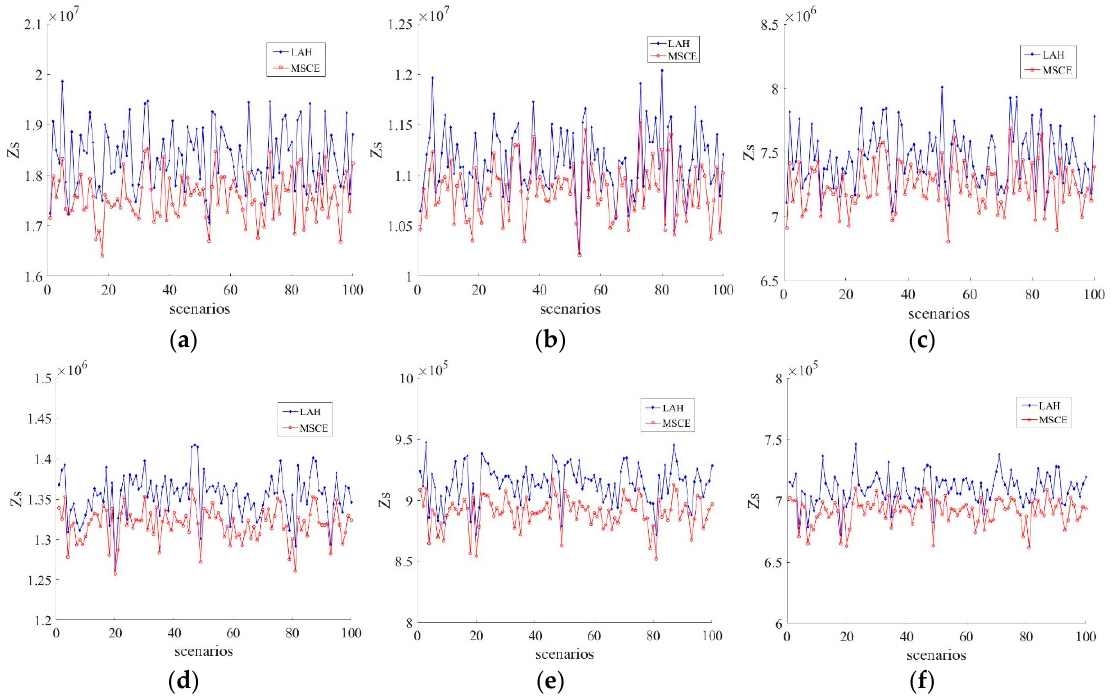
Figure 2. The computational results for H-95 and C-668. ( a ) H-95 with p = 10; ( b ) H-95 with p = 20; ( c ) H-95 with p = 30; ( d ) C-668 with p = 10; ( e ) C-668 with p = 20; and ( f ) C-668 with p = 30. Table 1. The computational time of 51 runs for all 100-scenario